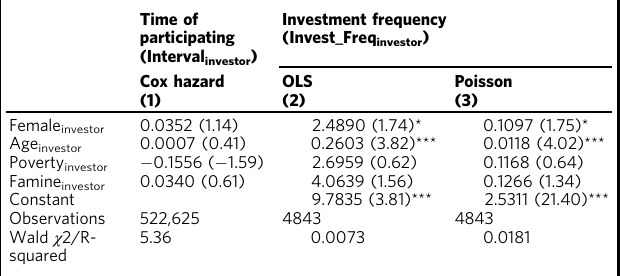
Table 2 Investor gender/age and the timing of joining the scheme and investment activeness.